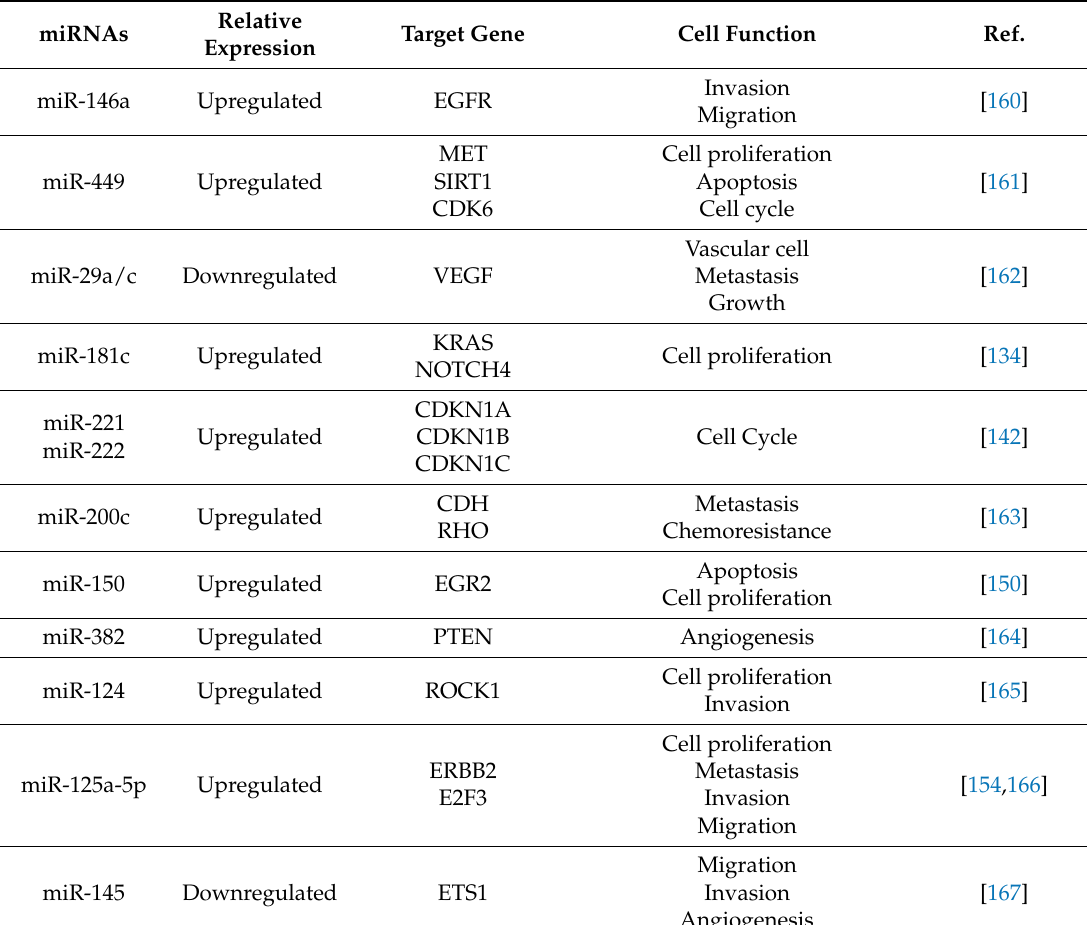
Table 5. Expression and deregulation of miRNAs in gastric